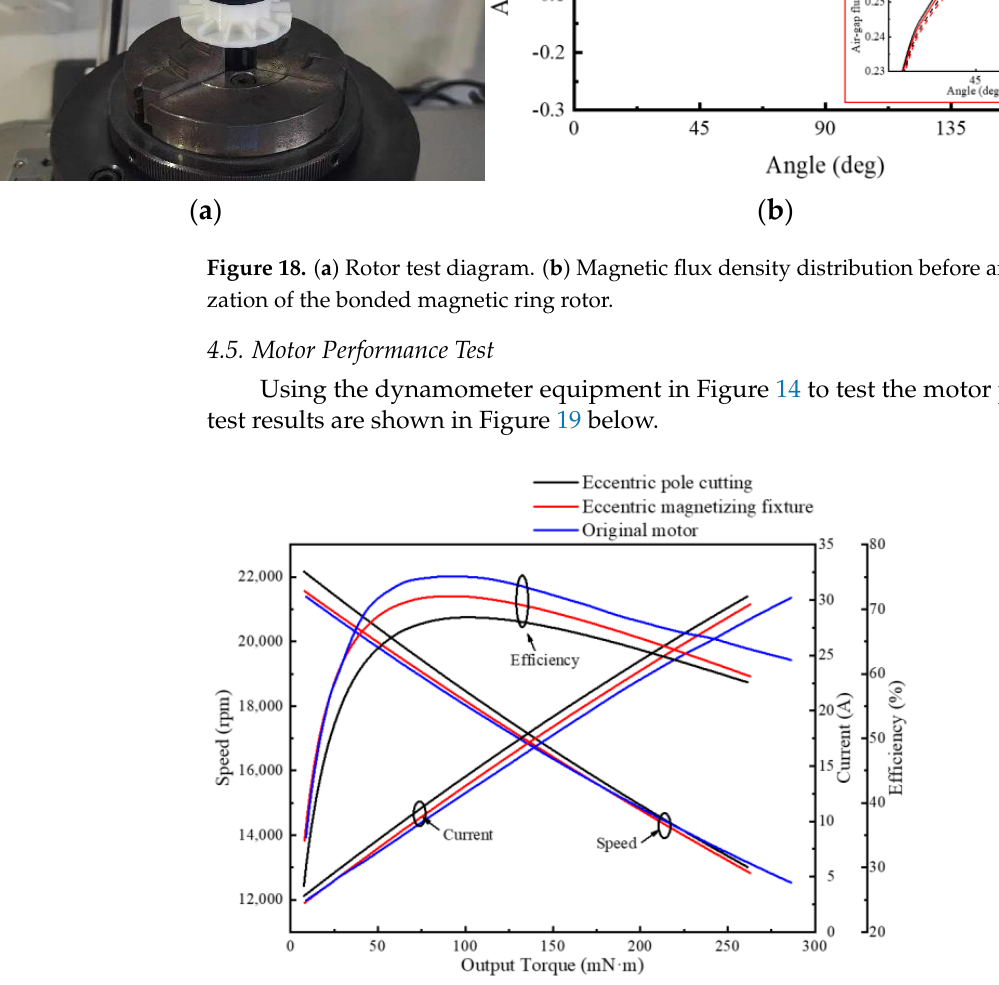
Figure 18. ( a ) Rotor test diagram. ( b ) Magnetic flux density distribution before and after demag- netization of the bonded magnetic ring rotor.